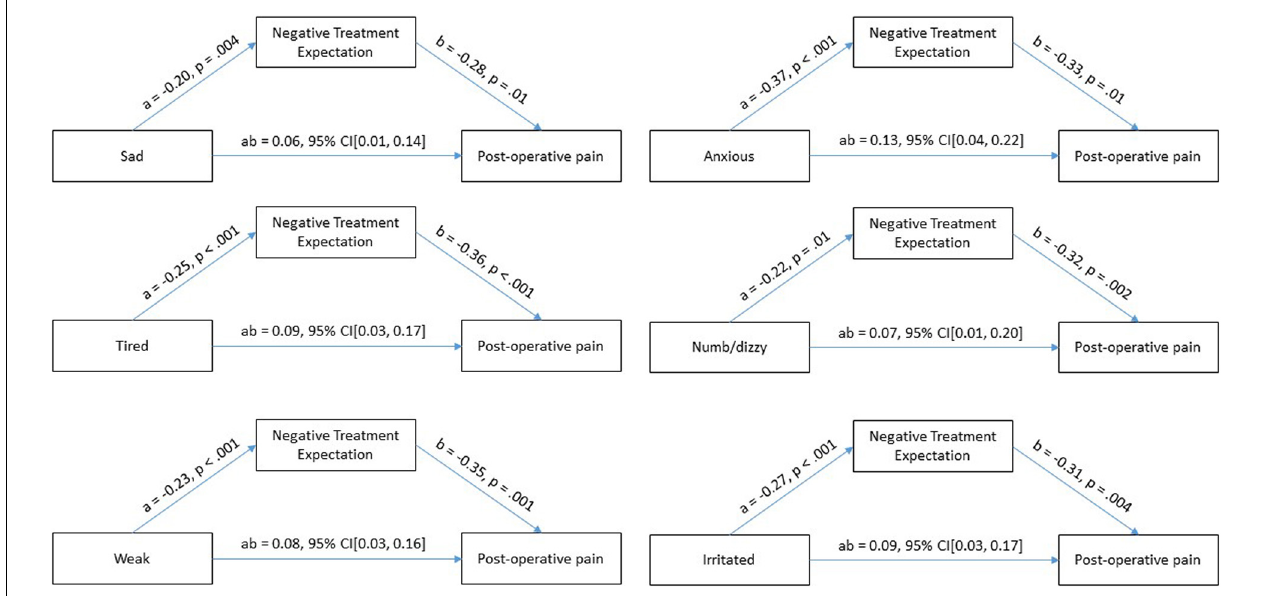
FIGURE 2 | Test of mediation effect of treatment expectation on emotional states and postoperative